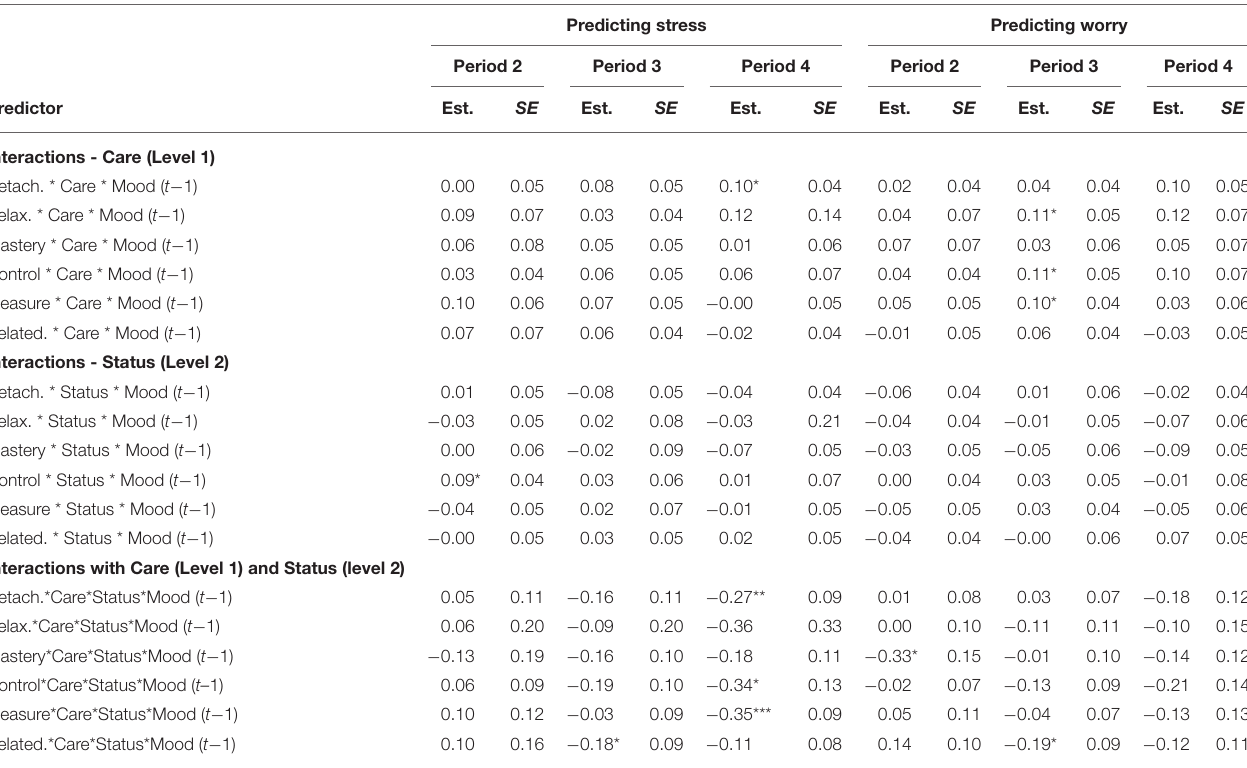
TABLE 3 | Results of the multilevel structural equation model estimating relationships between pandemic-related momentary negative mood, care for a dependent, marital status, and recovery experiences. Predicting stress Predicting